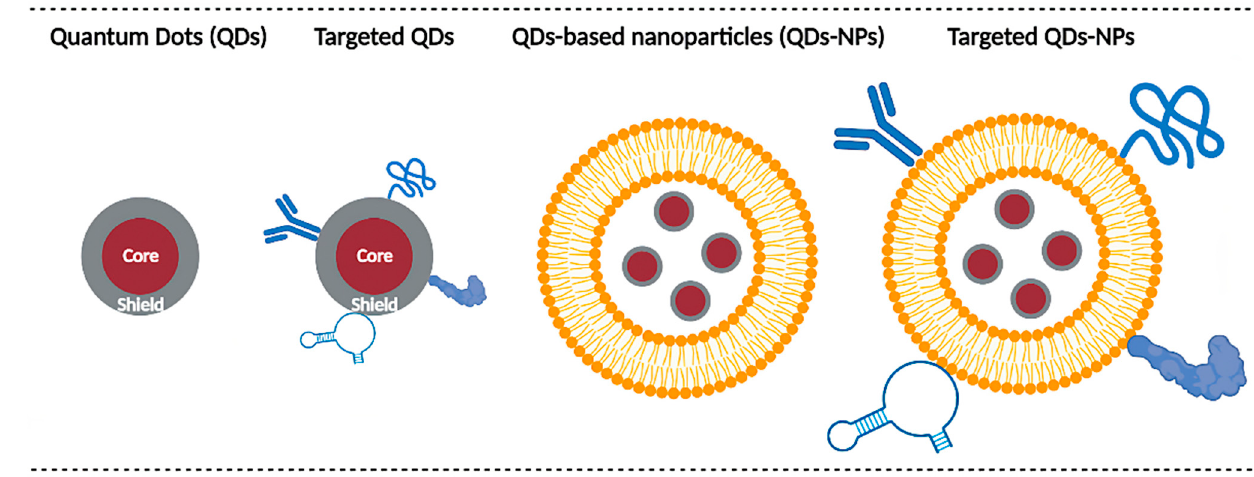
Figure 1. Main QDs delivery strategies. Delivery can rely on the intrinsic properties of QDs (size, charge, coating, etc.) or QDs can be functionalized with various ligands (e.g., antibodies, peptides, proteins, aptamers, etc.) for active targeting purposes. Another possibility is to encapsulate QDs in larger nanoparticles (e.g., micelles, liposomes, polymeric nanoparticles, etc.) to improve their biodistribution. These nanoparticles can themselves be modified for active targeting.